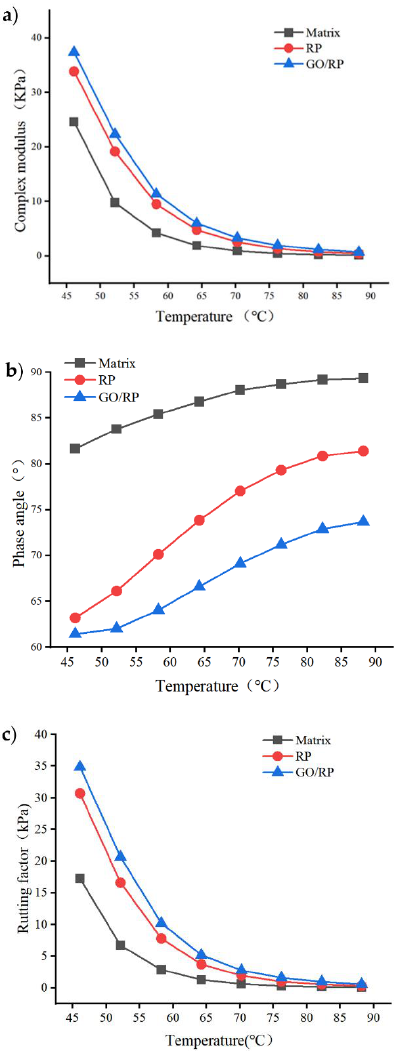
Figure 1. Temperature scanning test results: ( a ) complex modulus test results; ( b ) phase angle test results; ( c ) rutting factor temperature curves of three kinds of asphalt.